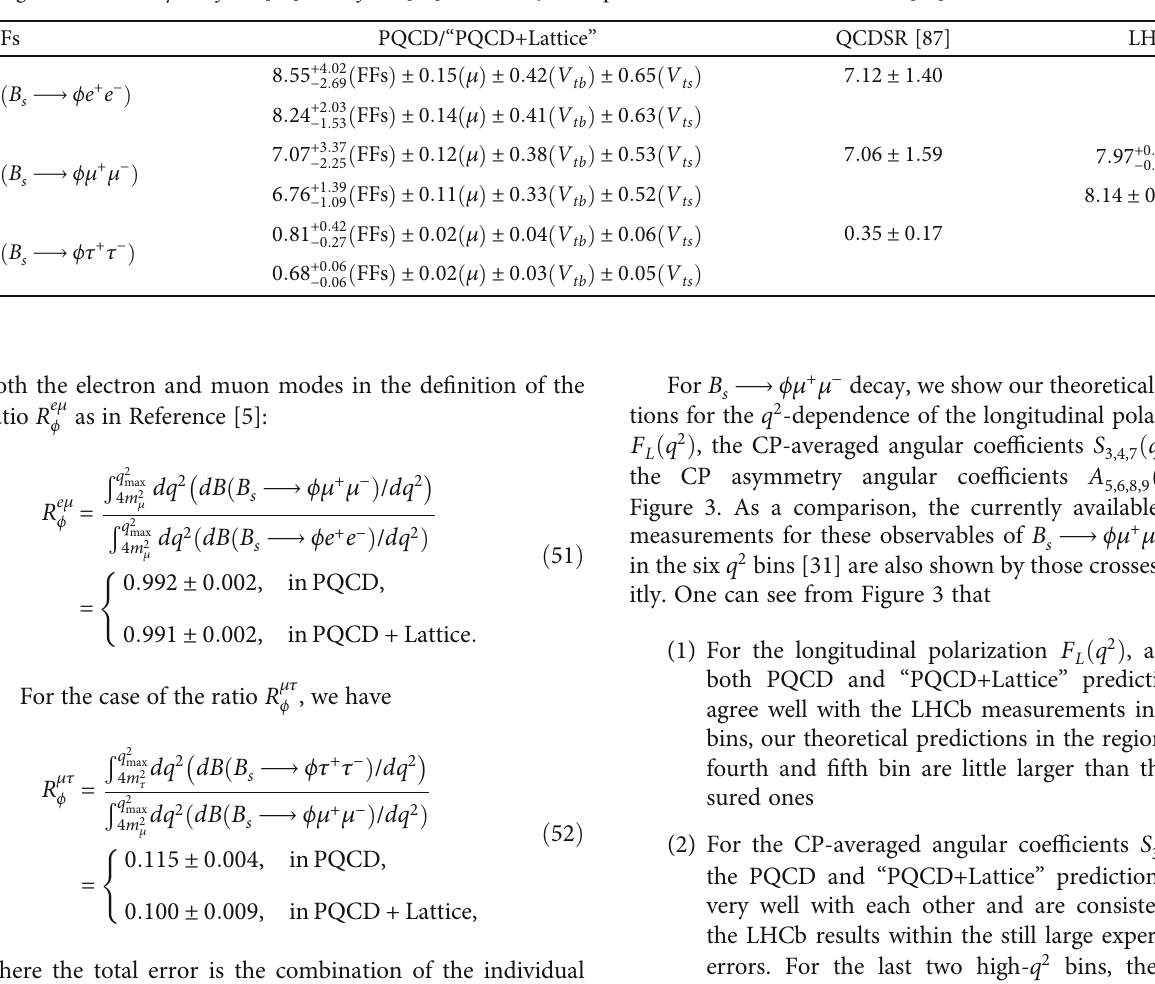
Figure 2: Theoretical predictions for the q 2 -dependence of di ff erential branching fraction dB / dq 2 for the semileptonic decays B in the PQCD (red band) and “ PQCD+Lattice ” (blue band) approach, respectively. The crosses show the LHCb measurements in di ff erent bins as given in Reference [31] (orange ones) and in Reference [33] (black ones). The vertical grey blocks are the experimental veto regions.